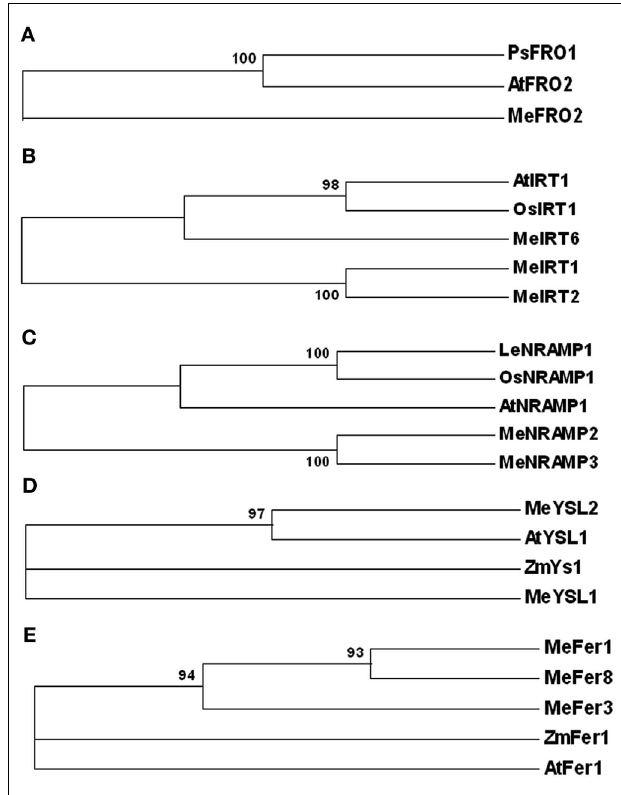
FIGURE 7 | Phylogenetic relationships of Manihot esculenta metal transporters and storage proteins. Bootstrap values from 1,000 replicates are indicated at each node. (A) FRO family; Species designations are as follows: At, A. thaliana (AtFRO2); Ps, P. sativum (PsFRO1); Me, M. esculenta (MeFRO2). (B) IRT family; Species designations are as follows: At, A. thaliana (AtIRT1); Os, O. sativa (OsIRT1); Me, M. esculenta (MeIRT1, MeIRT2, and MeIRT6). (C) NRAMP family; Species designations are as follows: At, A. thaliana (AtNRAMP1); Os, O. sativa (OsNRAMP1); Le, Lycopersicum esculentum (LeNRAMP1); Me, M. esculenta (MeNRAMP2, MeNRAMP3). (D) YSL family; Species designations are as follows: At, A. thaliana (AtYSL1); Zm, Zea Mays (ZmYS1); Me, M. esculenta (MeYS1, MeYSL2). (E) Ferritin family. Species designations are as follows: At, A. thaliana (AtFER1); Zm, Zea Mays (ZmFER1); Me, M. esculenta (MeFER1, MeFER3, and